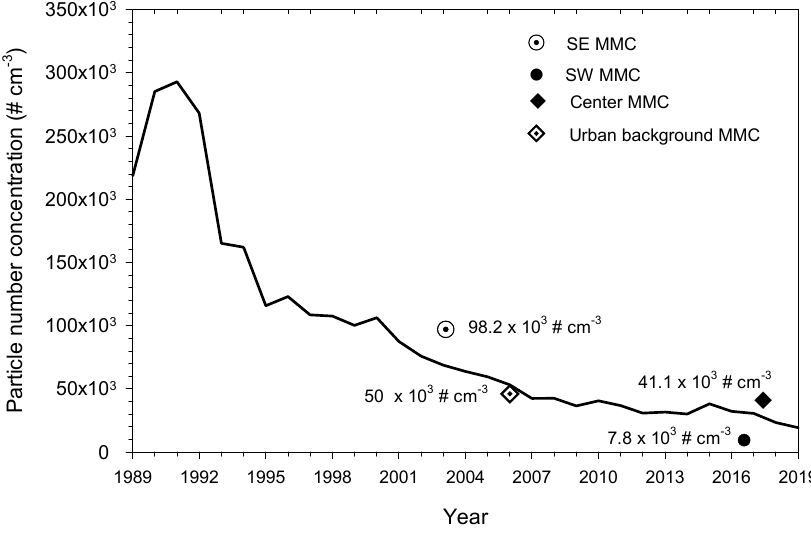
Figure 2. Annual trends of PNC of NPs estimated from the medians of annual measured and estimated PM 2.5 and CO registered by all monitoring stations of the MMC from 1989 to 2019. The symbols in the figure correspond to the median PNC and the date of measurement reported by: Dunn et. al. [53], commercial with median industry and heavy traffic site, size of measured NPs between 3–15 nm; ● Caudillo et al., [54] residential with low traffic site, size of measured NPs between 20–100 nm; ◆ Velasco et al., [55] commercial with moderate to heavy traffic, size of measured NPs < 50 nm; Kleinman et al. [64], PNC urban background estimated from the extrapolation down to surface of the average NPs with sizes < 100 nm measured by aircraft across the MMC at an altitude average level of 350 m above surface. Source of data was obtained at: http://www.aire.cdmx.gob.mx/default.php# accessed on 13 January